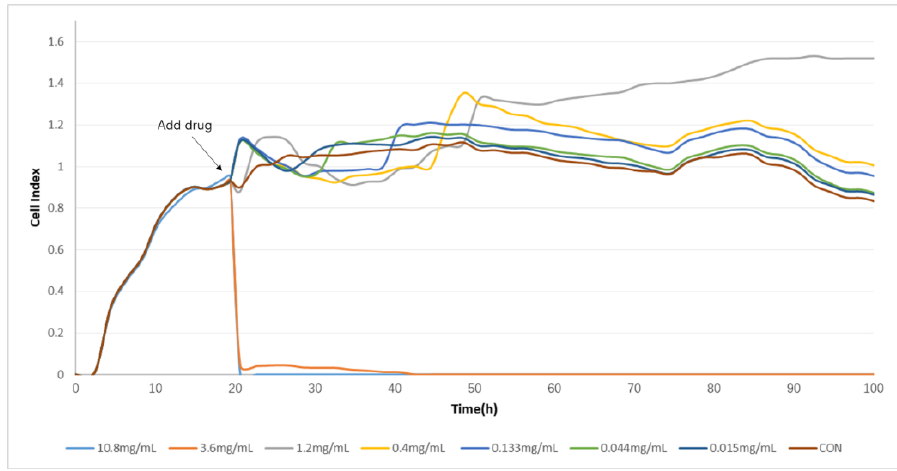
Figure 3. The time/dose-dependent cell response profiles (TCRPs) of the different concentration samples of Compound Danshen Dripping Pills (CDDPs) acting on Hela cells plotted against time with the mean of three experiments. The concentrations are: 10.8 mg/mL (light blue line), 3.60 mg/mL (medium brown line), 1.20 mg/mL (gray line), 0.400 mg/mL (yellow line), 0.133 mg/mL (medium blue line), 0.044 mg/mL (green line), 0.015 (dark blue line), and control (dark brown line).